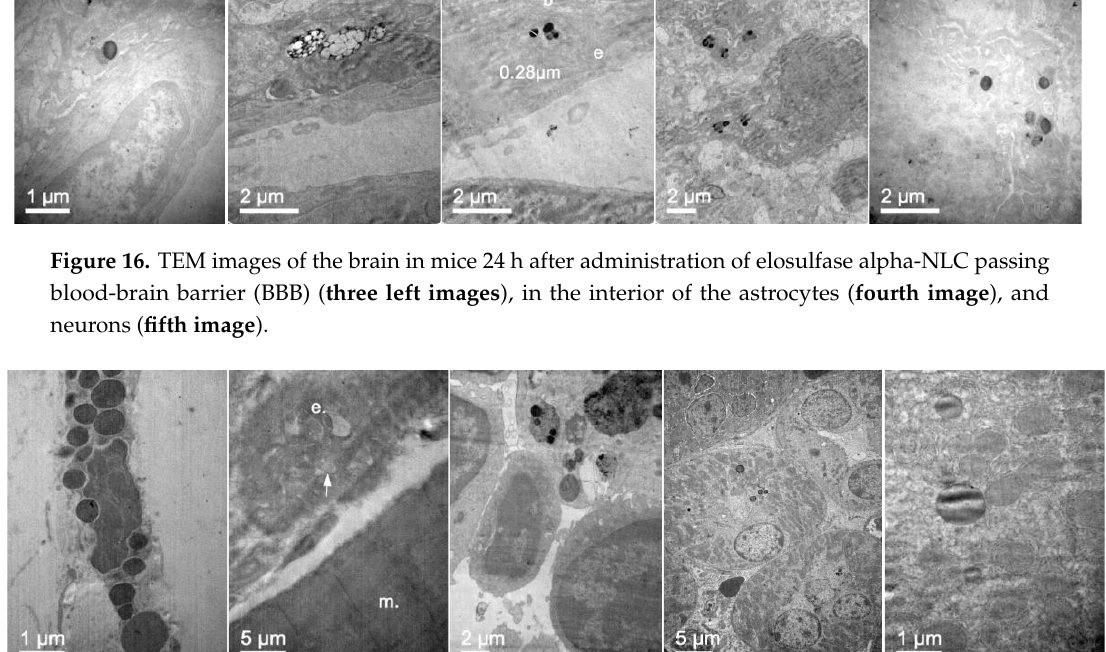
Figure S1. DSC curves of the solid lipids used to prepare the lipid shell of the NLC; Figure S2. XRD patterns of solid lipid after you process in same conditions that used in NLC production; Figure S3. DSC curves of the mixtures of the solid and liquid lipids used to prepare the NLC lipid shell; Figure S4. XRD patterns of mixtures of lipid and solid lipid used to prepare the NLC lipid